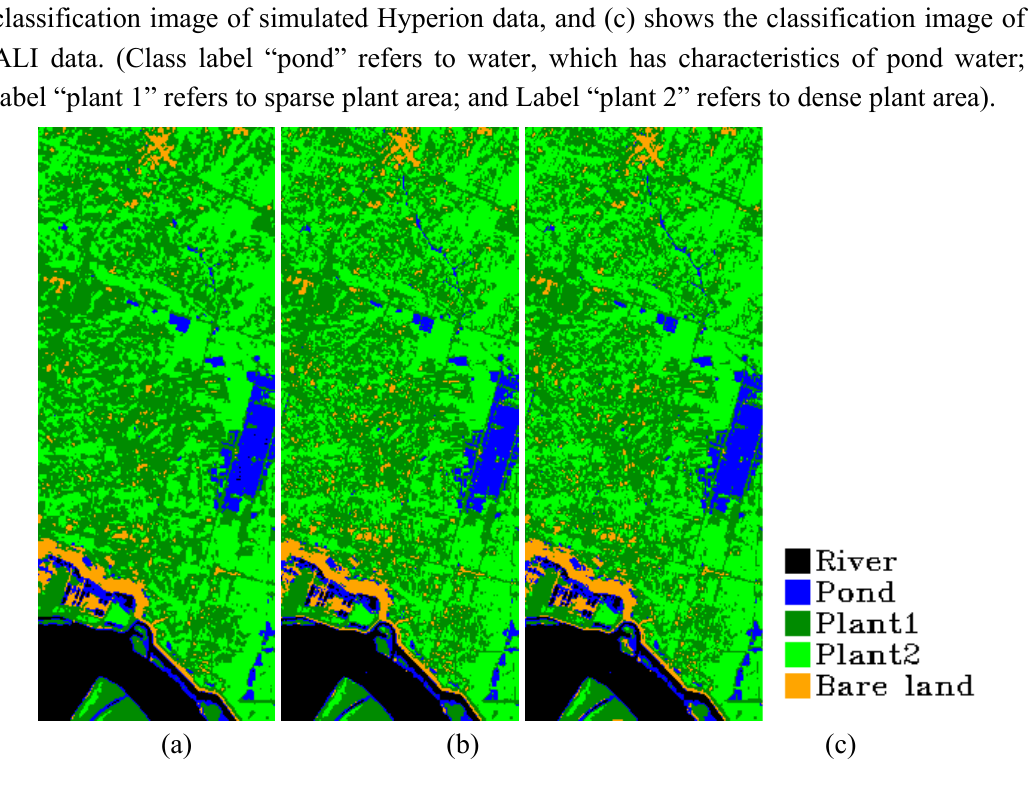
Table 2 . Classification accuracies of simulated Hyperion data and ALI data using the classification results of original data as reference